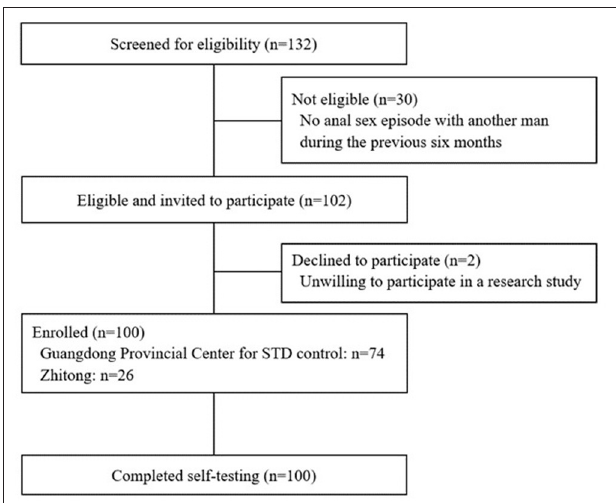
FIGURE 1 | Flowchart of the study population.